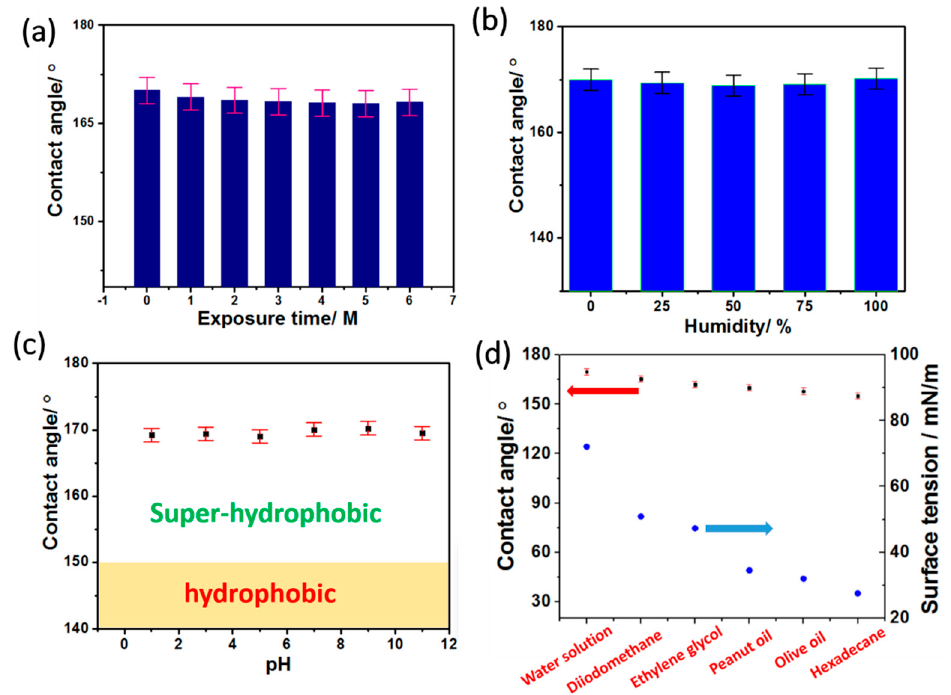
Figure 6. The contact angle as a function of exposure time ( a ), humidity ( b ), pH ( c ), and the different kinds of droplets ( d ).